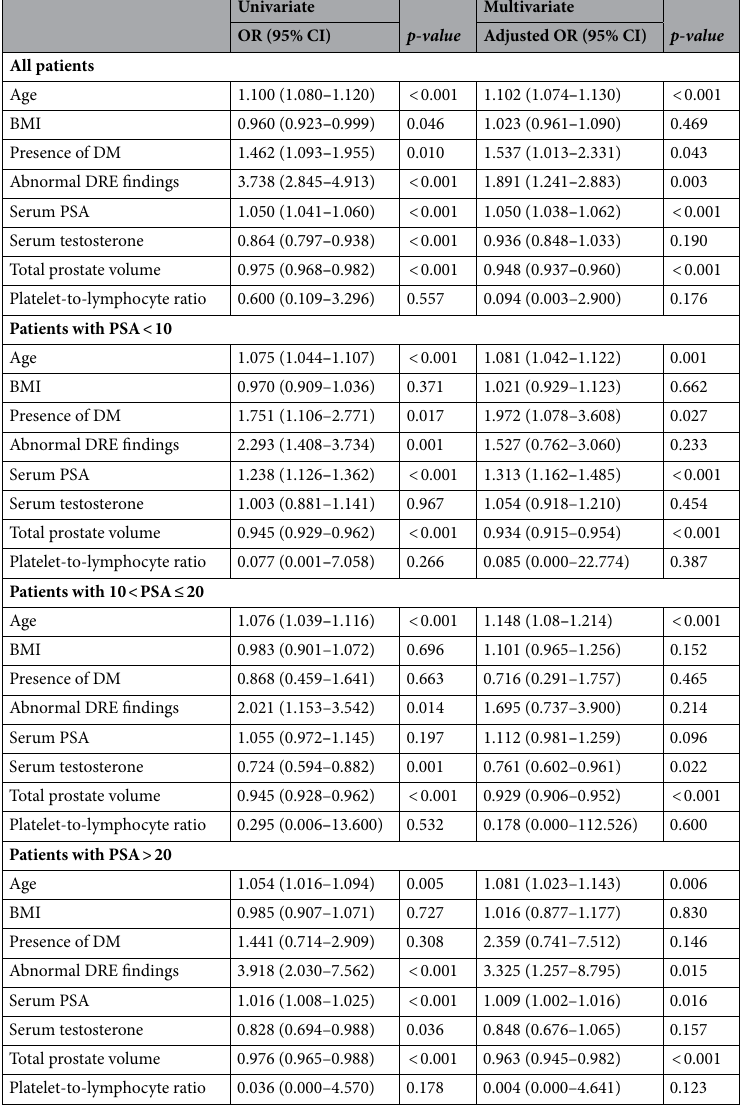
Table 3. Univariate and multivariate regression analyses to identify predictors of clinically significant prostate cancer (vs. benign disease + clinically insignificant prostate cancer) at the standard 12-core TRUS-Bx.